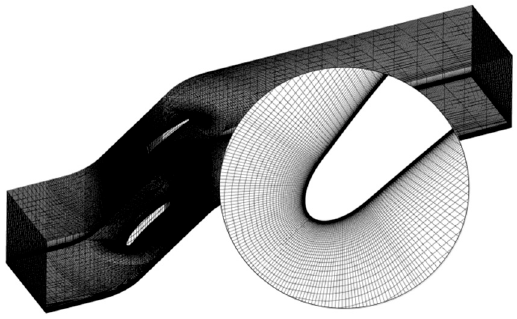
Figure 19 . The computational mesh of the cascade .